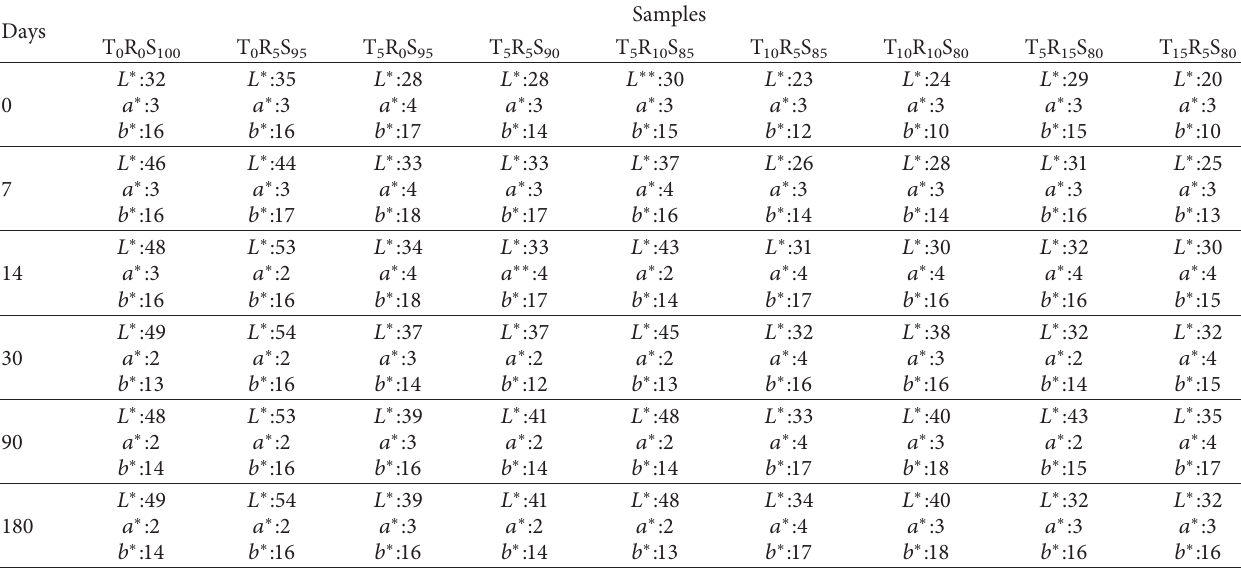
Table 5: L ∗ a ∗ b ∗ parameters of specimens in different mass ratio during different durations. Days